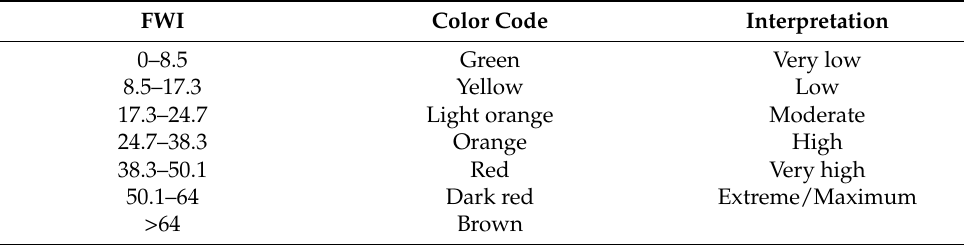
Table 1. Fire Weather Index (FWI) scale and interpretation. FWI Color